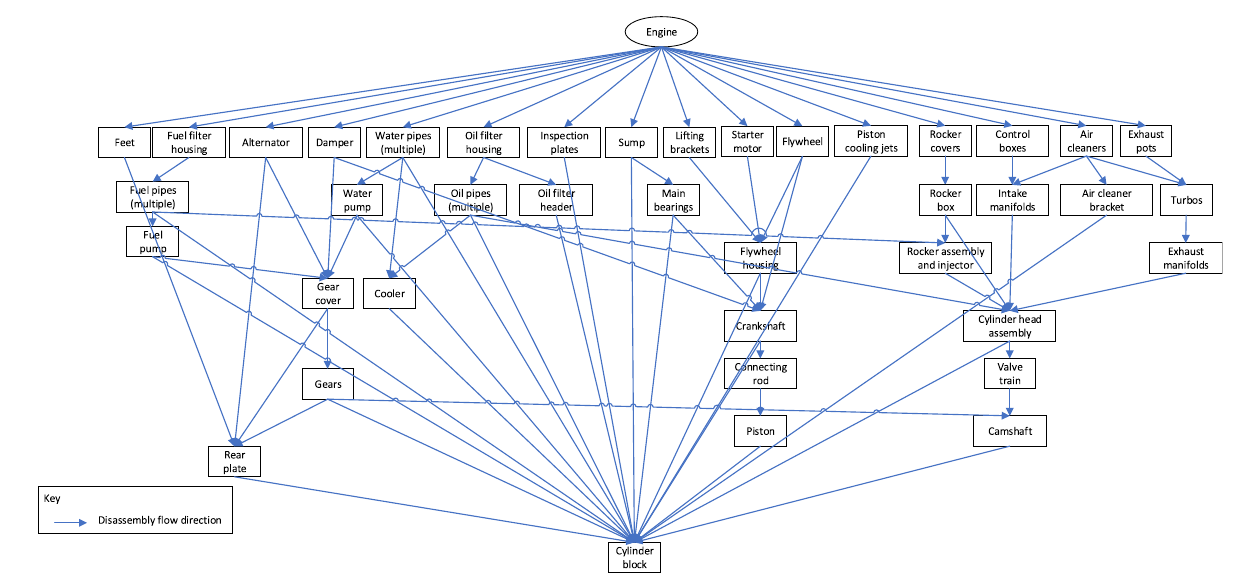
Figure 4. High-level disassembly precedence relationship between engine